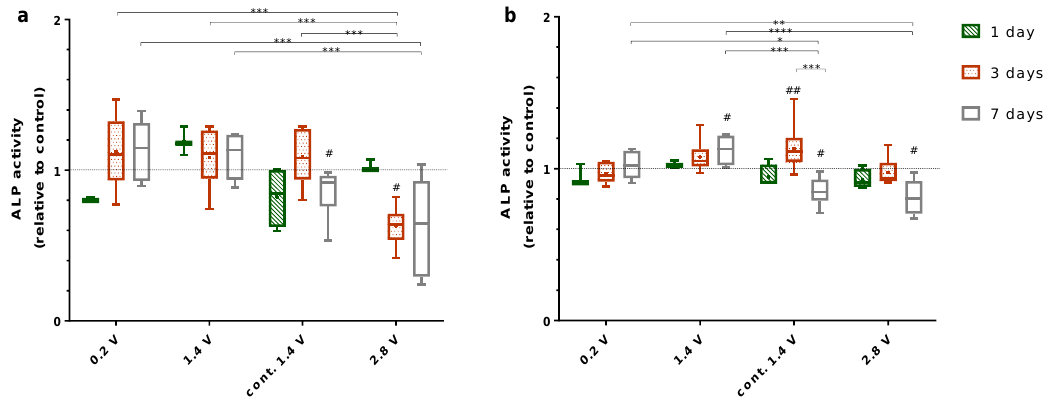
Figure 5. Alkaline phosphatase activity (ALP) of human osteoblasts growing on electrodes ( a ) and coverslips ( b ) with and without electrical stimulation. Results are displayed relative to the unstimulated controls after one, three, and seven days. For this experiment, 0.2 V, 1.4 V, and 2.8 V groups were stimulated 3 × 45 min per day, while the cont. 1.4 V group was stimulated continuously with 1.4 V. # indicates significant differences between the stimulated and control groups: # p < 0.05 and ## p < 0.01 (Wilcoxon matched pair test), * indicates significant differences between stimulation groups: * p < 0.05, ** p < 0.01, *** p < 0.001 and **** p < 0.0001 (two-way ANOVA). n ≥ 3.